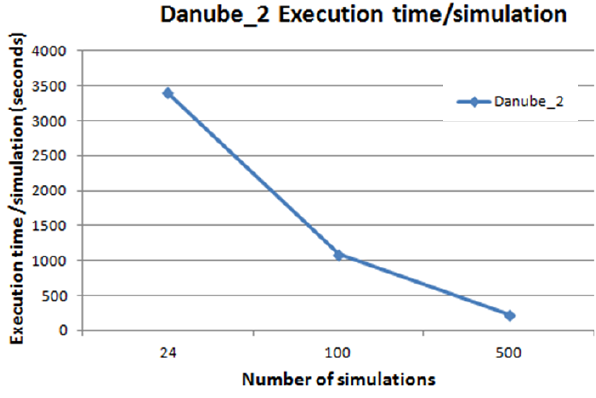
Fig. 12. Danube 2 execution per simulation over the